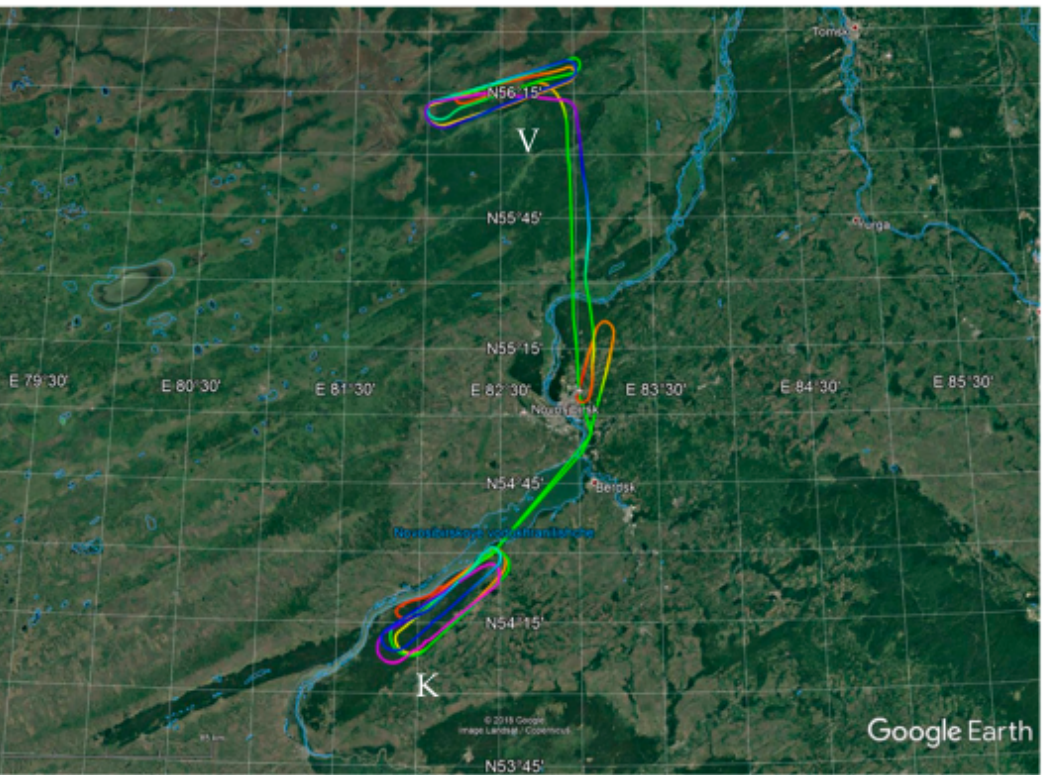
Figure 1. Route of the aircraft moving during sampling of aerosols over the Vasyugan marshes and Karakansky pine forest. Index V is for the region of the Vasyugan marshes (the starting point coordinates of backward trajectories are 56.00 N; 82.30 E), index K is for the region of the Karakan pine forest (the starting point coordinates of backward trajectories are 54.22 N; 82.15 E).